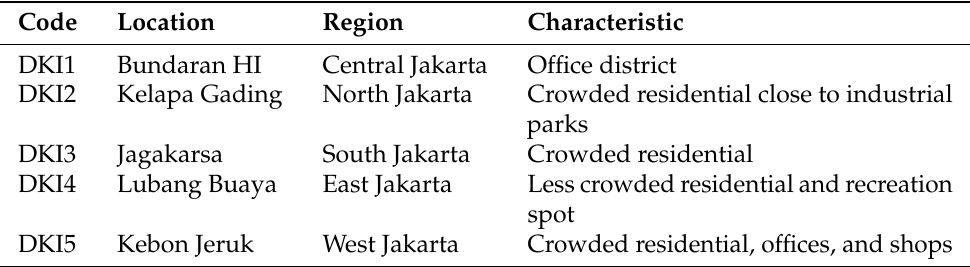
Figure 2. Air Quality Measurement Locations in Jakarta. Table 2. Measurement location